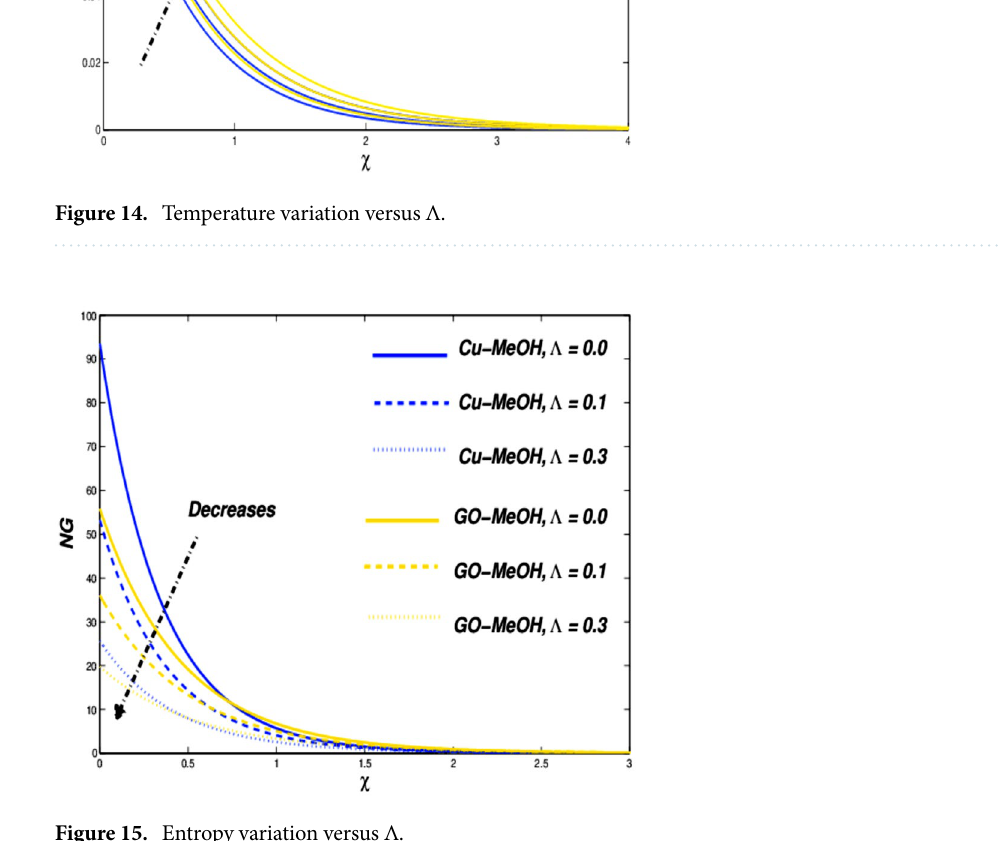
Figure 15. Entropy variation versus (cid:31)